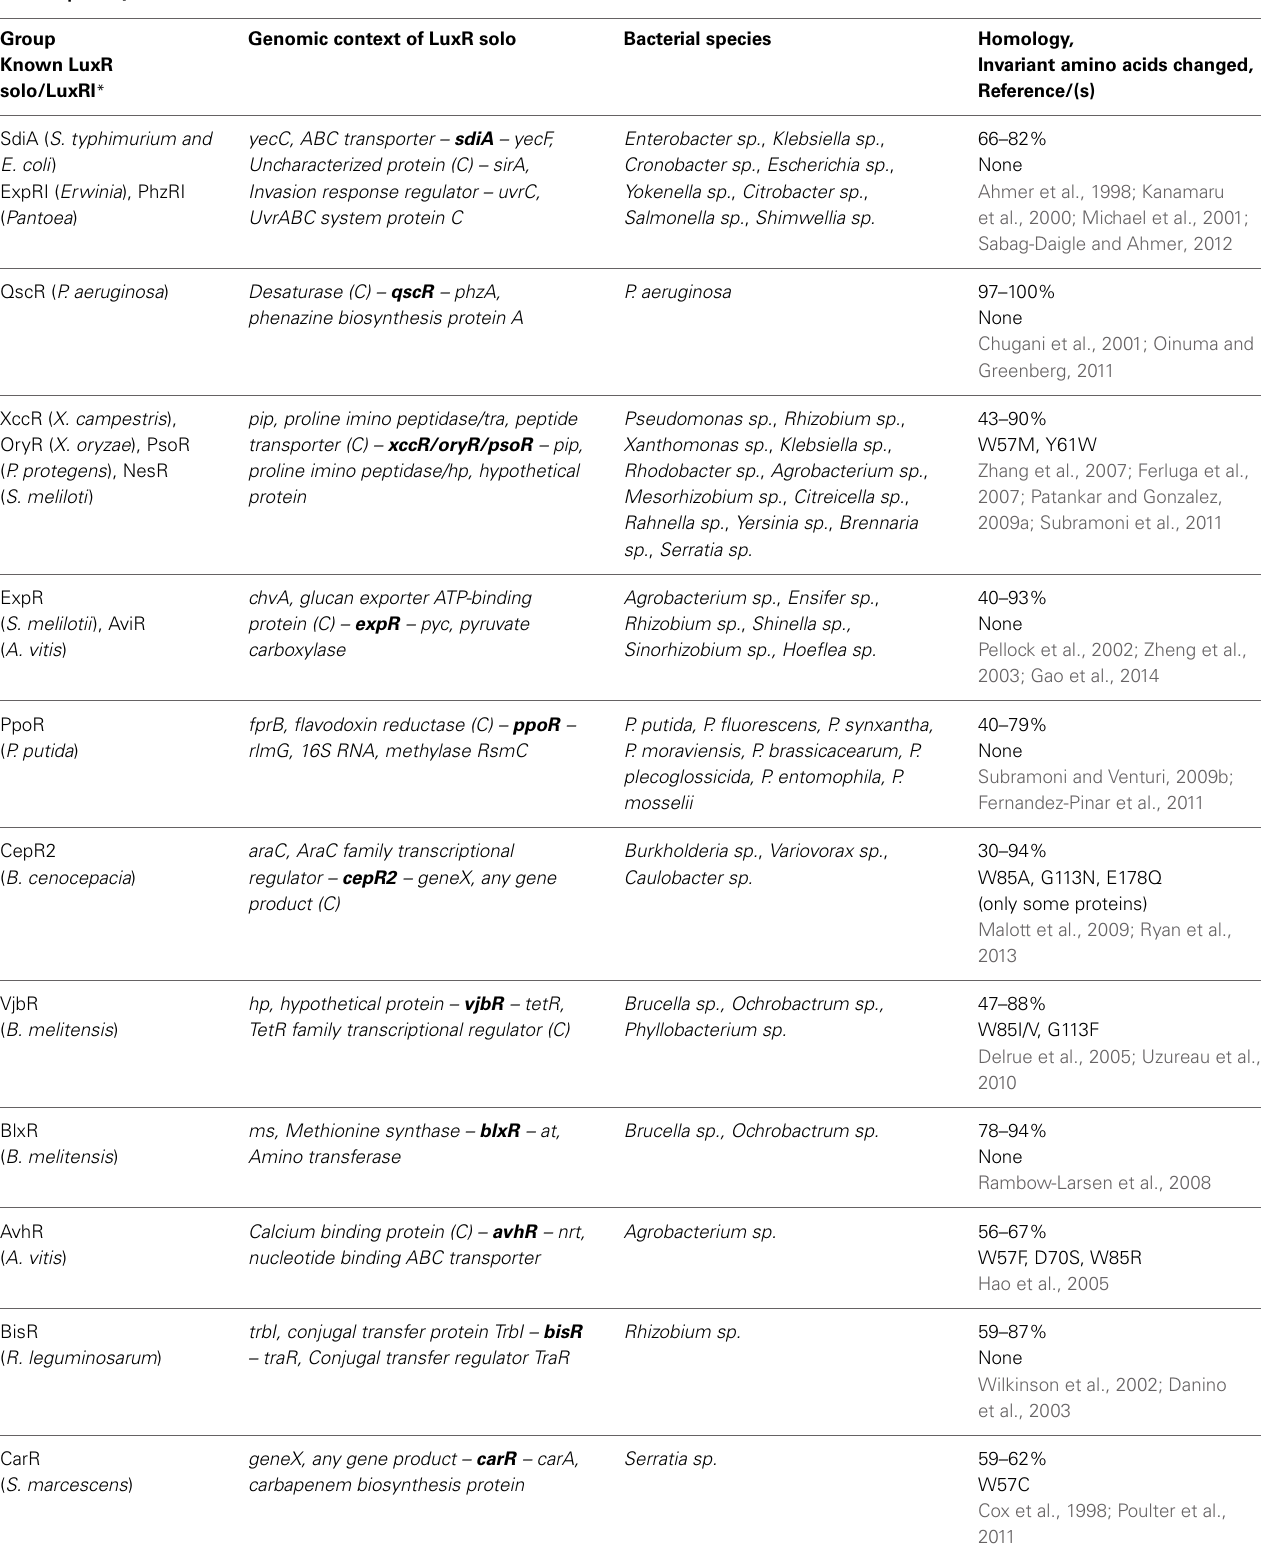
Table 3 | Groups of known LuxR